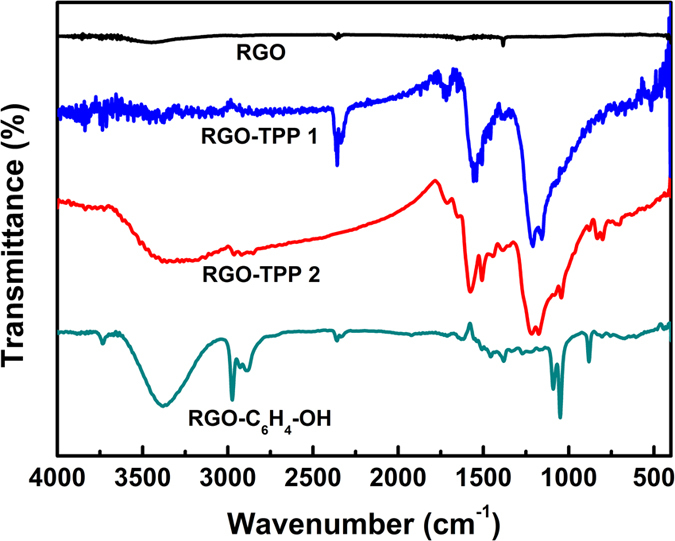
FTIR spectra of RGO, RGO-C6H4-OH, RGO-TPP 1 and RGO-TPP 2.